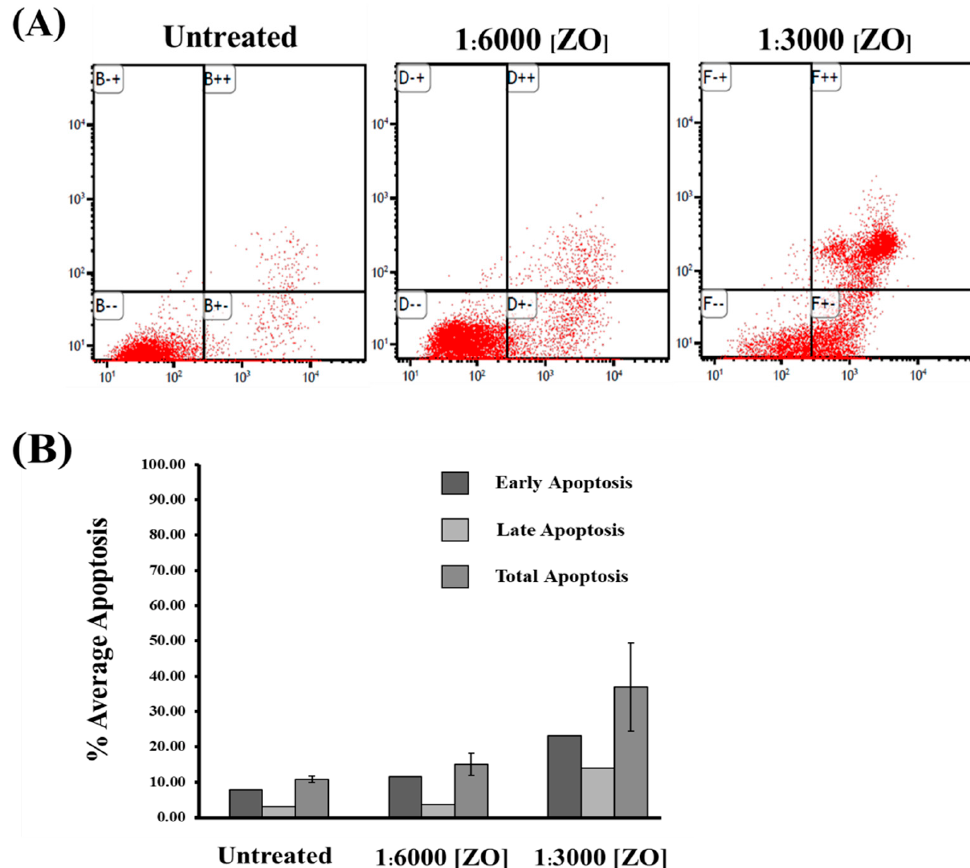
Figure 2. The effect of ZO essential oil on HeLa cell apoptosis. ( A ) A representative histogram for flow cytometry demonstrating HeLa cell apoptosis after 24 h of treatment with different dilutions (1:6000 and 1:3000) of ZO essential oil and stained with annexin V/PI. ( B ) Quantitative analysis representing the average percentage of apoptotic HeLa cells at the early, late apoptosis, and total apoptosis in HeLa cells treated with 1:6000 or 1:3000 dilutions of ZO essential oil for 24 h.